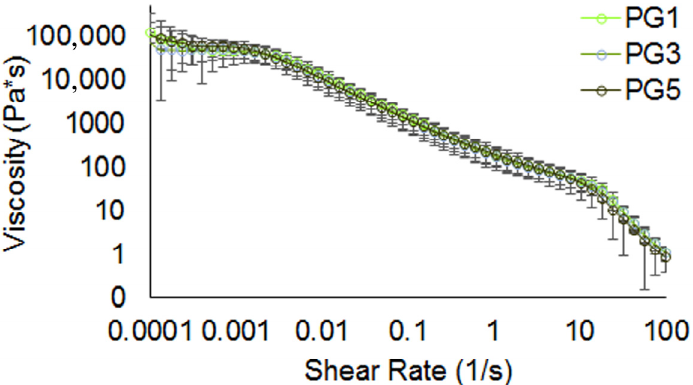
Figure 4. Flow curves of boluses from PGs.